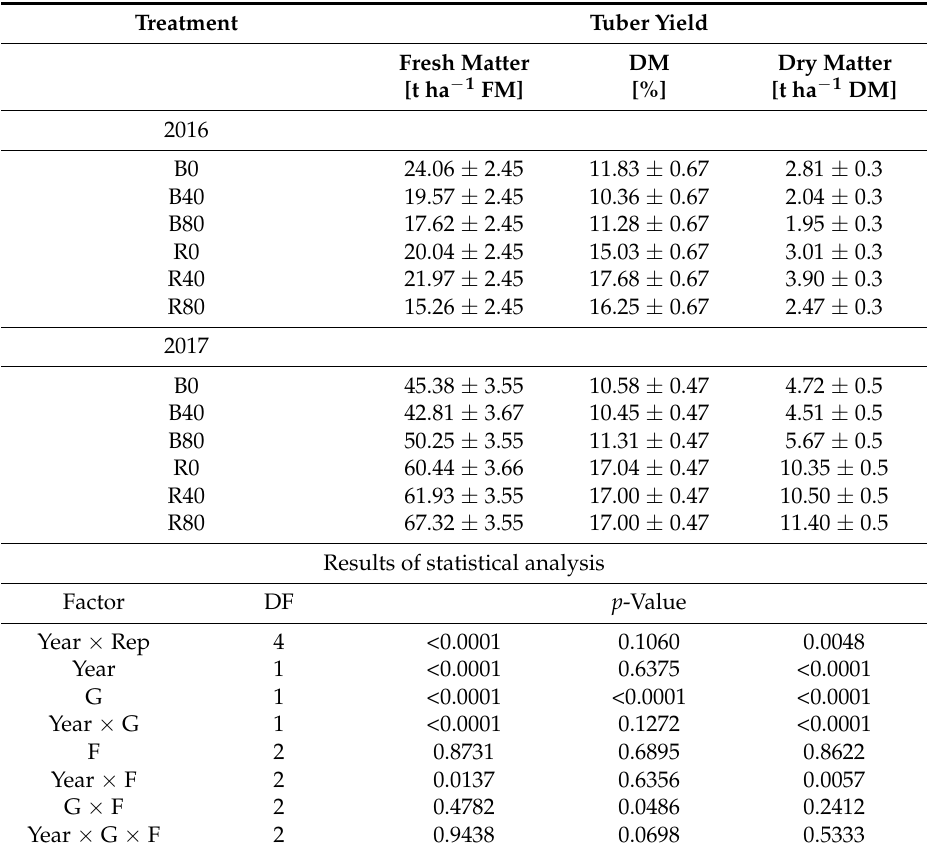
Table 3. Tuber yield (t ha − 1 FM), tuber dry matter (DM in %), and tuber yield (t ha − 1 DM) for the two years (2016 and 2017) of the six treatments (B0, B40, B80, R0, R40, and R80) at harvest as mean value ± standard